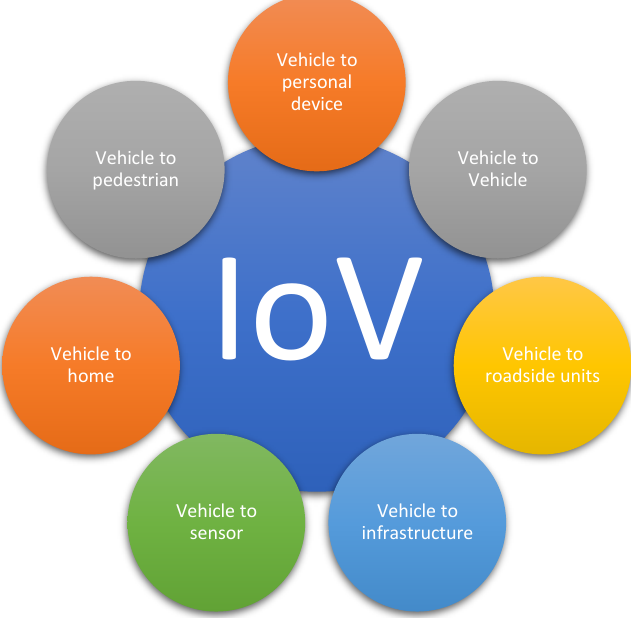
Figure 1. Communications for vehicles in the IoV environment.